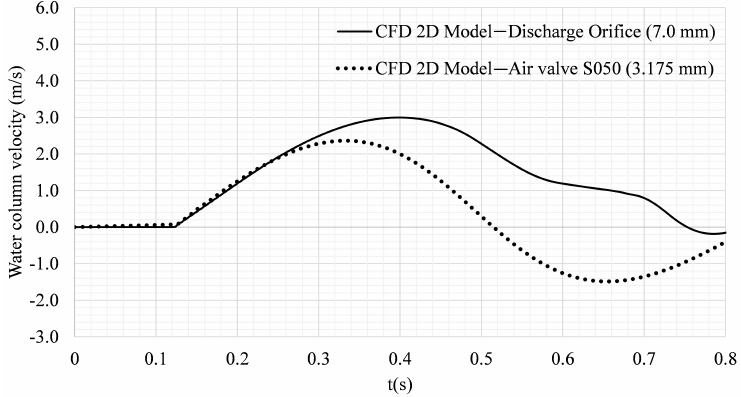
Figure 8. Comparison of water column velocity patterns using the S050 air valve (diameter of 3.175 mm) and the 7.0 mm discharge